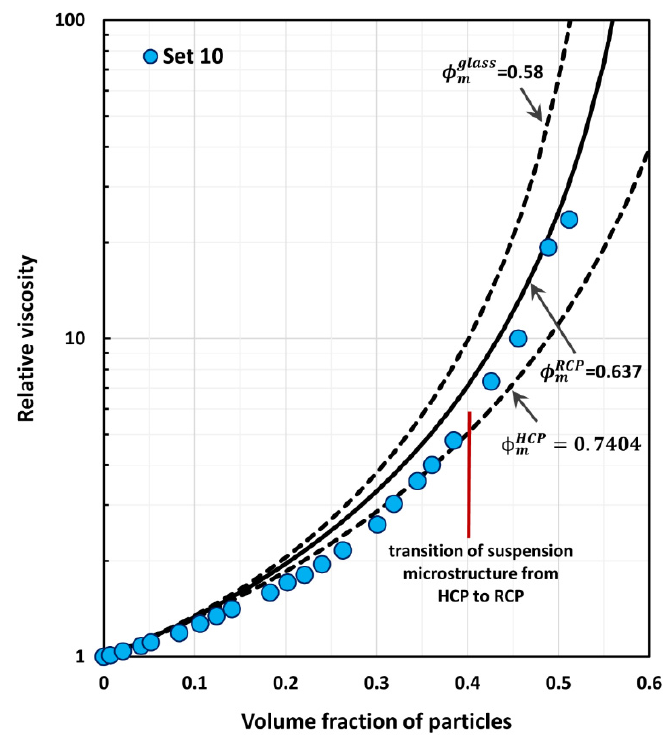
Figure 15. Transition in suspension microstructure from hexagonally close packed (HCP) clusters to randomly packed clusters (RCP) at a particle volume fraction of about 0.40.